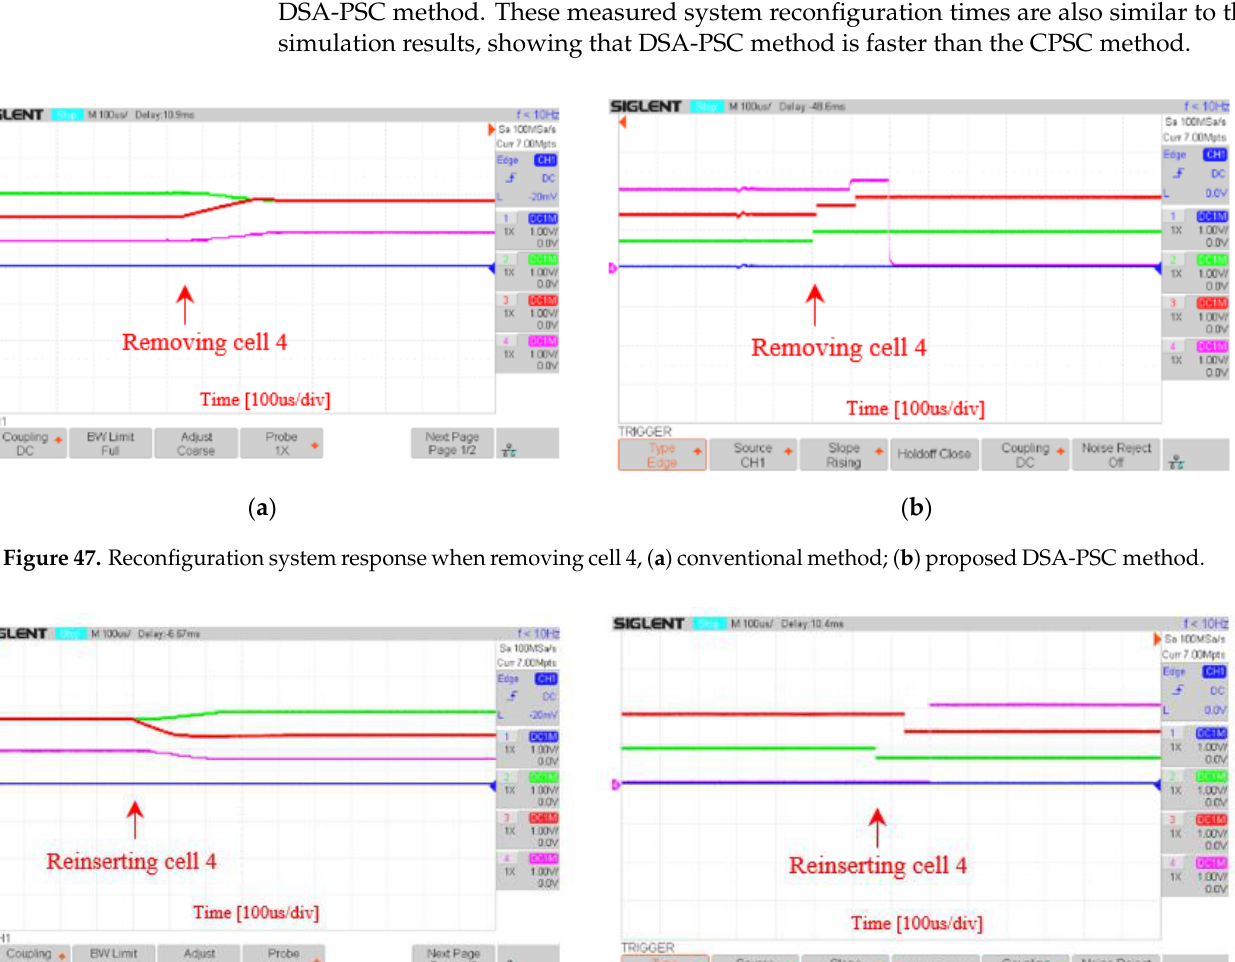
Figure 46. FFT analysis of output voltage, ( a ) spectrum of nine first harmonics; ( b ) spectrum of 400 harmonics.